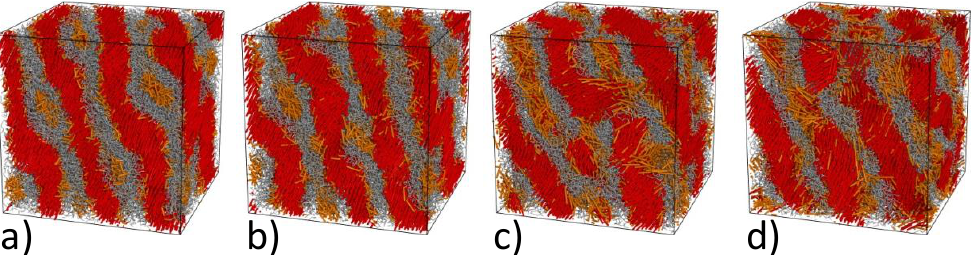
Figure 5. Snapshots of the triblock A 10 B 10 A x rod-coil-rod (red-gray-orange) copolymers at stronger immiscibility between A and B particles ( a AB = 50, a AA = a BB = 25) for x = 3 ( a ), x = 4 ( b ), x = 5 ( c ), and x = 6 ( d